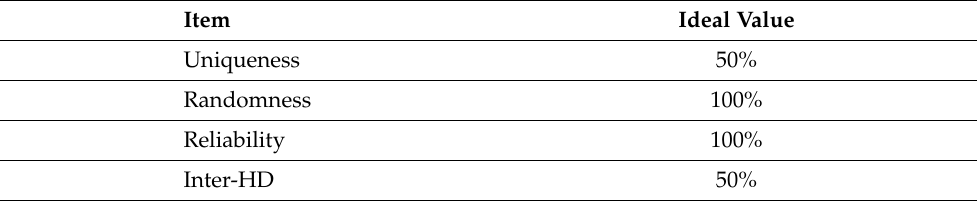
Table 2. Ideal characteristics of the PUF.